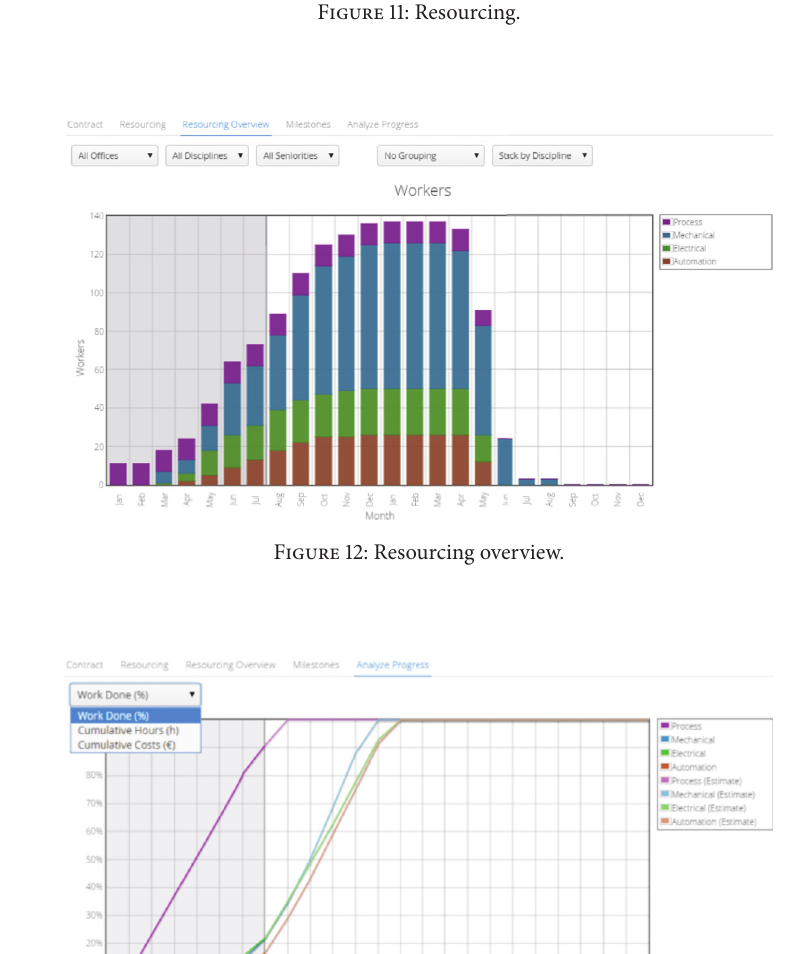
Figure 11: Resourcing.